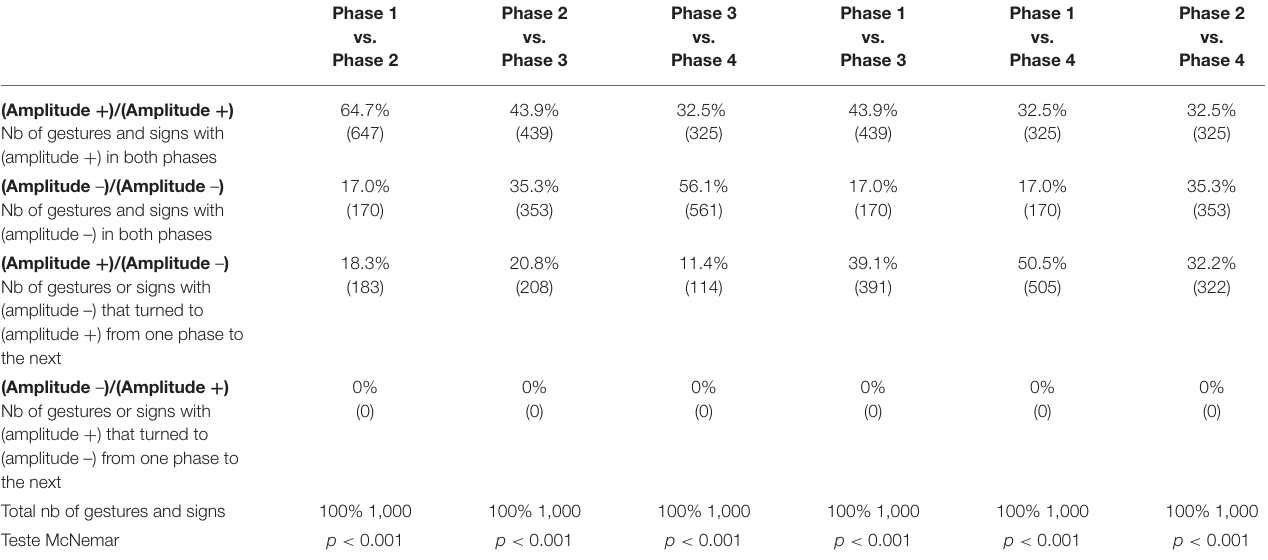
TABLE 6 | McNemar Test: Comparison of pair of phases based on the number of gestures or signs with amplitude ( + ) and amplitude (–) occurrences considering the analyzed 1,000 gestures and